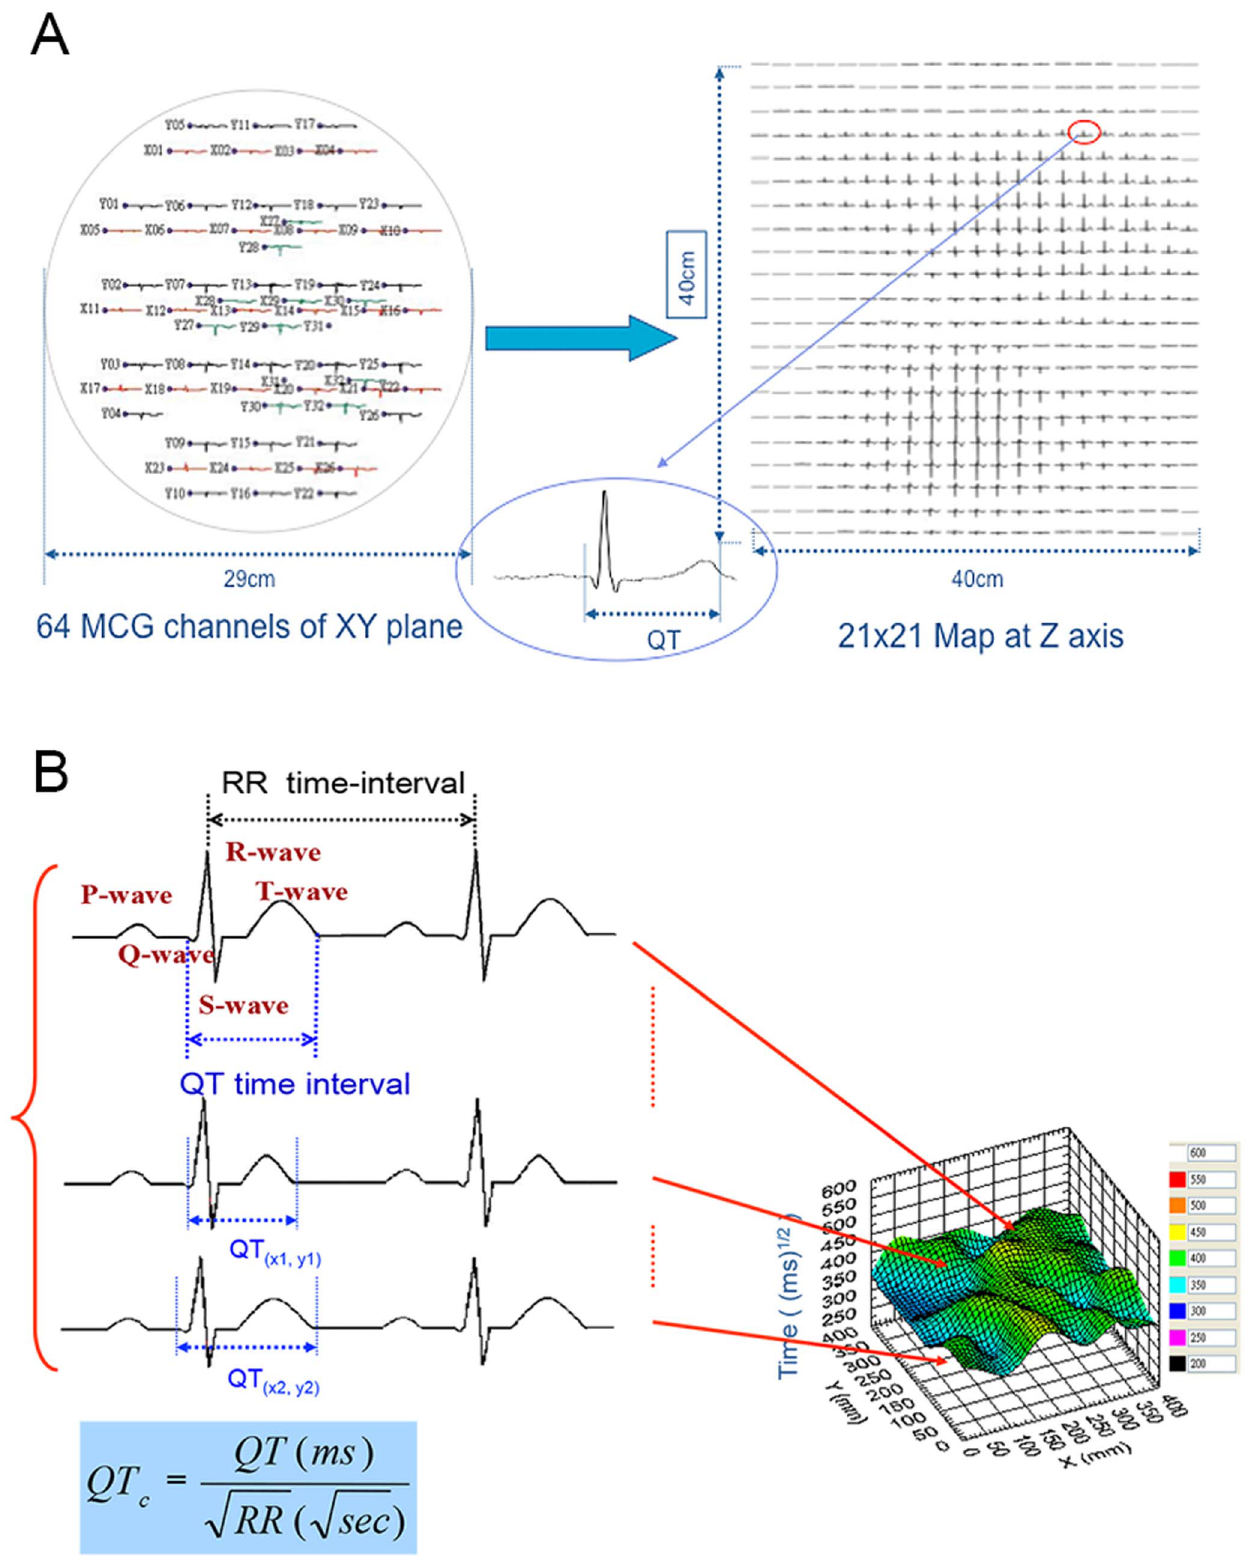
Figure 1. Construction of a QT c contour map from magnetocardiography (MCG). Signals from 64-channel MCG traces before averaging, and the construction of repolarization map with a 21 6 21 resolution by signal-averaged vector-projected electrocardiogram (A). The spatial distribution of corrected QT (QT c ) intervals was displayed on a QT c contour map (B).